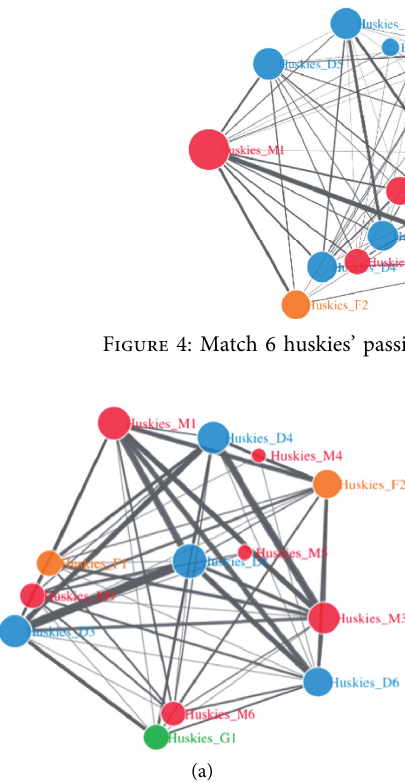
Figure 5: The comparison of original (a) and opponent’s interference (b) in the first stage of Match 6.